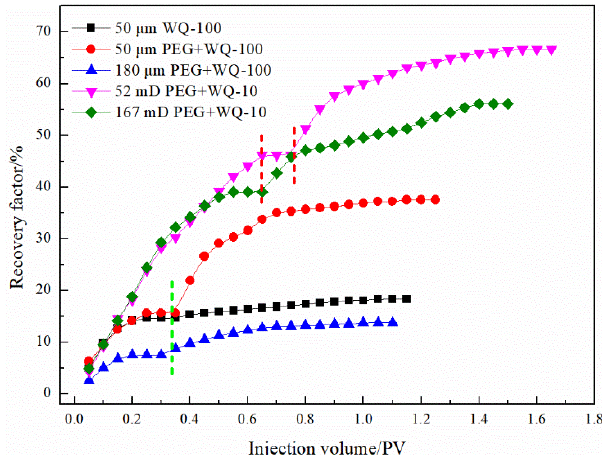
Figure 16. EOR effects of enhanced gels on fractured and pore-fractured reservoir.